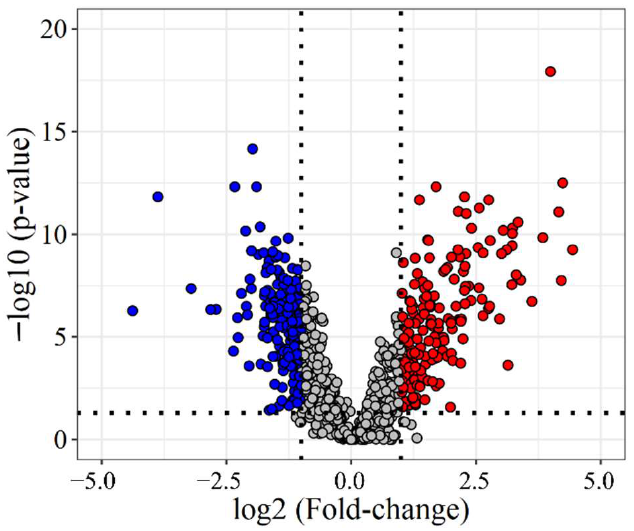
Figure 2. Volcano plot of all quantified proteins. Fold-change and p -values were calculated between all tumor and all adjacent tissue samples. Blue—significantly under-expressed in LC (FC < 0.5), red—significantly overexpressed in LC (FC > 2).